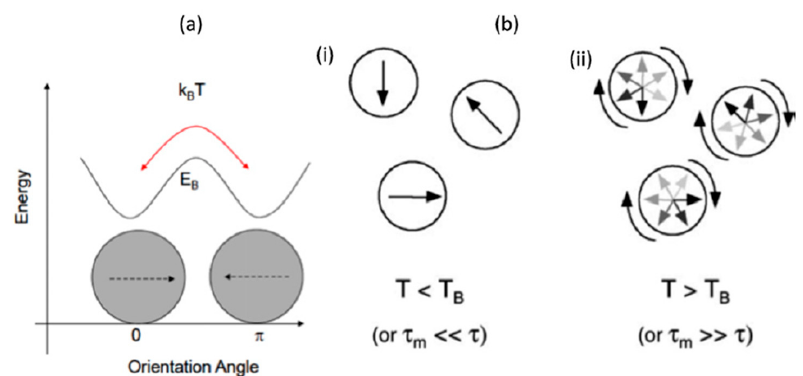
Figure 3. ( a ) Scheme of the energy needed, E B , for the magnetization of a nanoparticle to flip between the parallel and antiparallel orientations along the easy axis. ( b ) Superparamagnetic nanoparticles